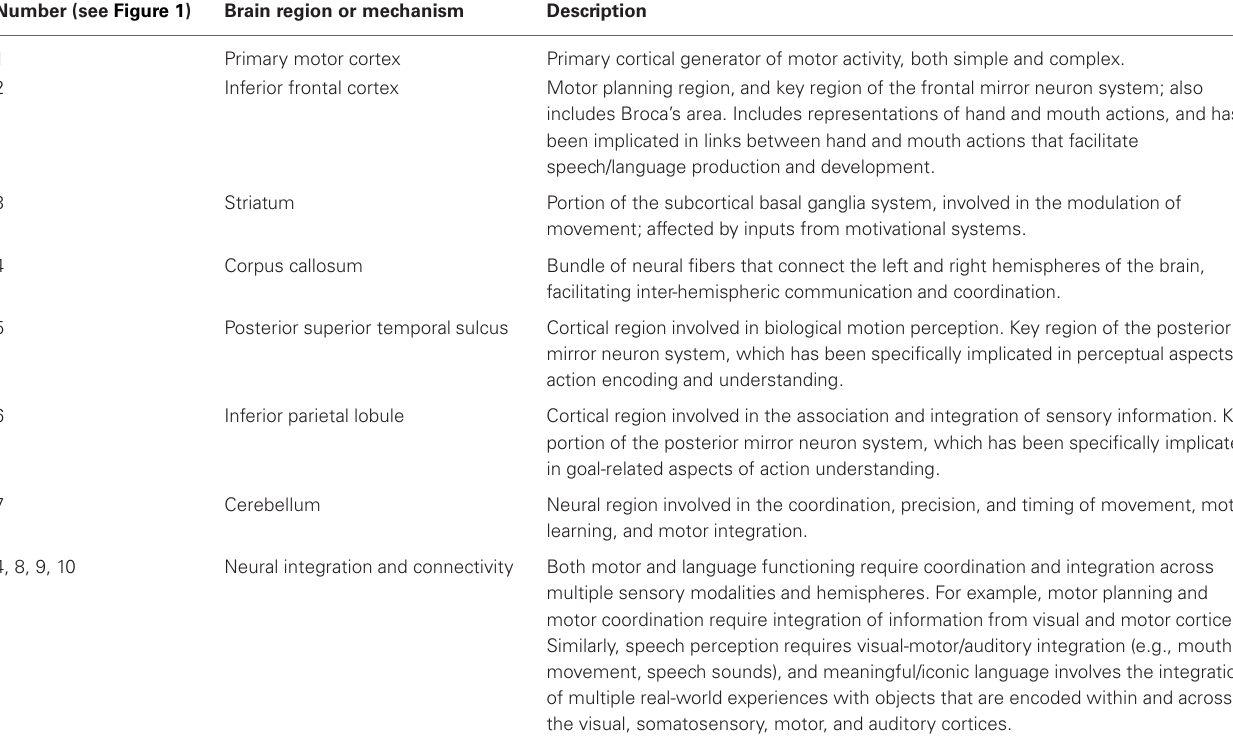
Table 1 | Brain regions and mechanisms associated with motor aspects of language